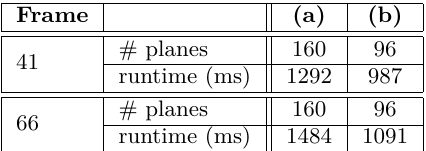
Figure 4. Qualitative evaluation on aerial imagery between. Row 1: Frame 41. Row 2: Frame 66. Column 1: Reference frame. Column 2: Estimated depth map with linear sampling in scene space. Column 3: Estimated depth map with linear sampling along the epipolar line in image space. Table 2. Quantitative evaluation between four different configurations on aerial imagery. (a) Linear sampling in scene space with 160 planes. (b) Linear sampling in image space with a disparity change of max. 1